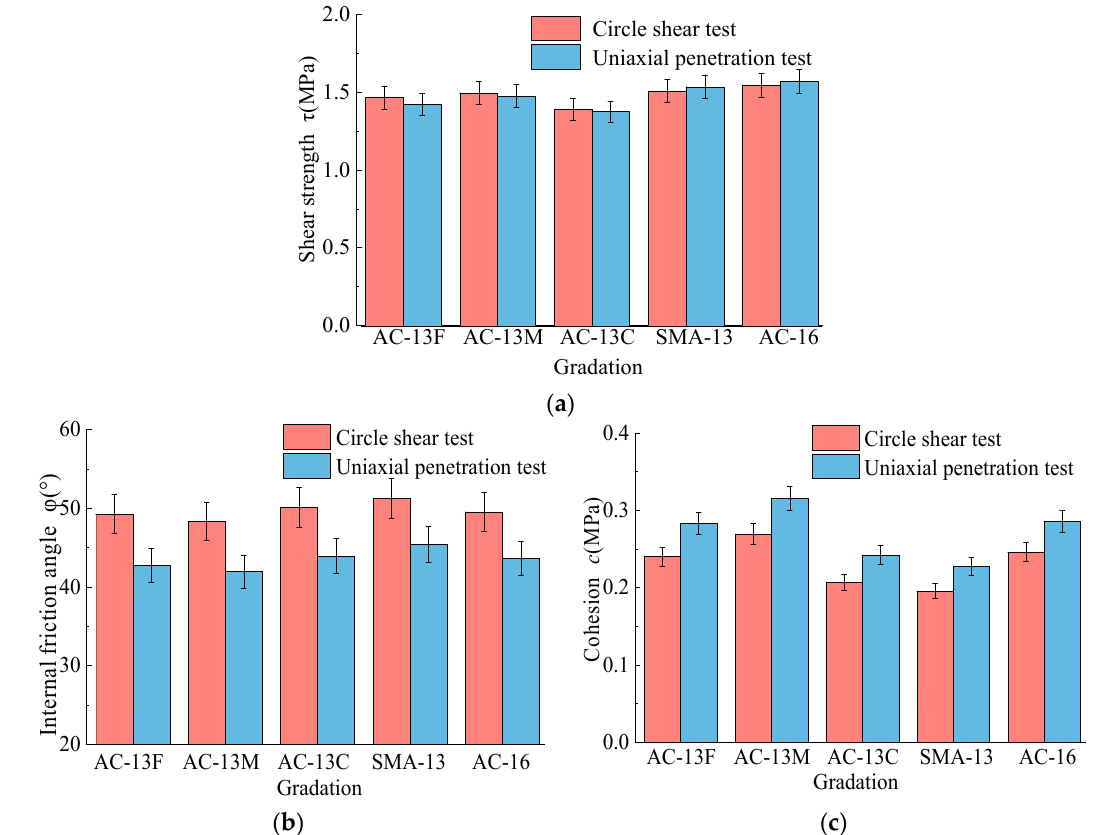
Figure 9. Shear strength, internal friction angle, and cohesion of mixtures with different gradations. ( a ) Shear strength; ( b ) Internal friction angle; ( c ) Cohesion.